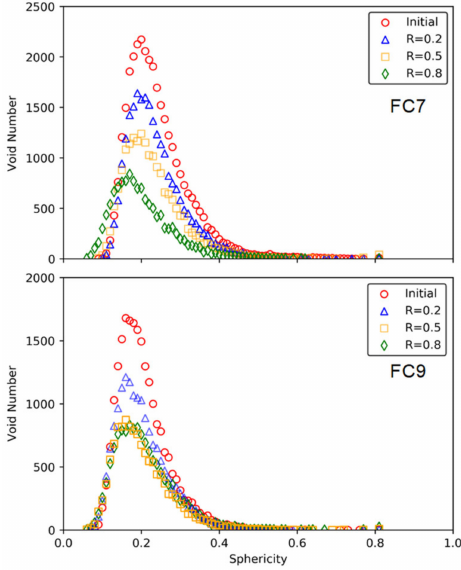
Figure 7. Variation of void sphericity after static loading.